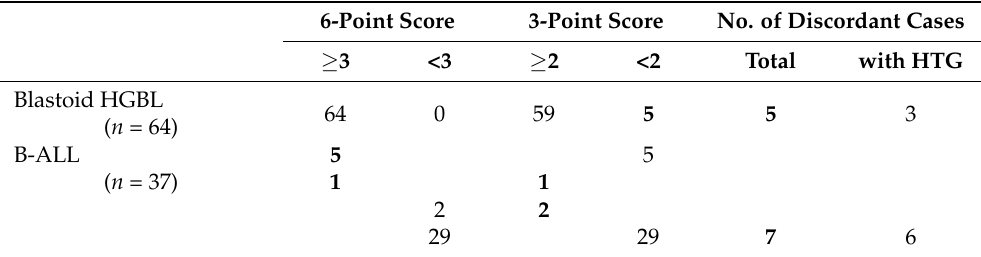
Table 3. Comparison of the two scoring systems in Blastoid HGBL and B-ALL. 6-Point